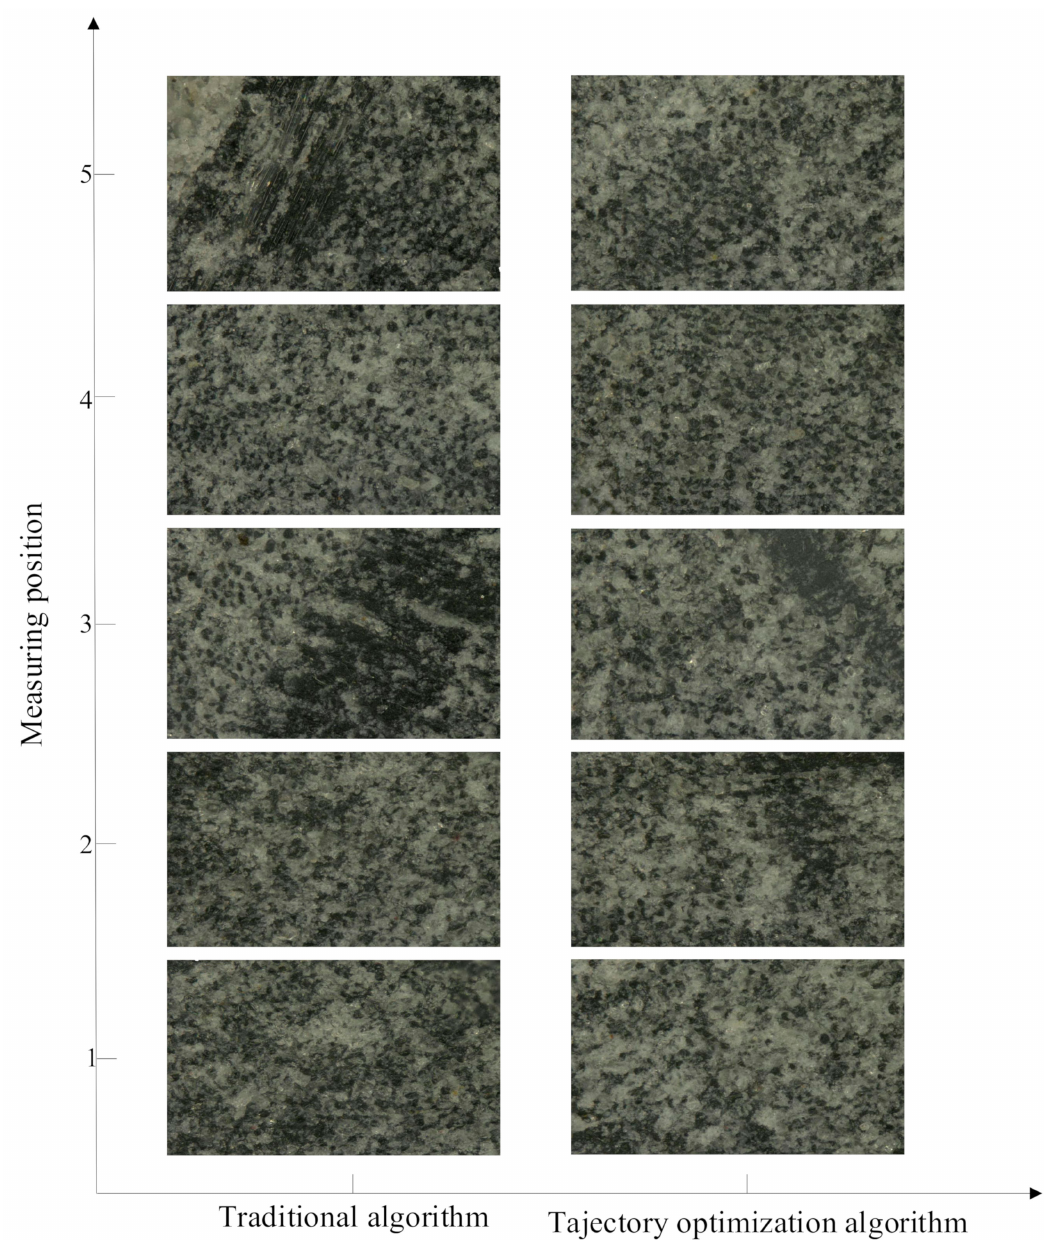
Figure 21. The topographical features when the magnification was 100 ×